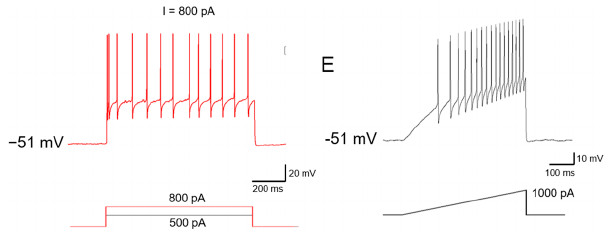
Figure 1. ( A ) Showing intact whole mount dorsal root ganglion (DRG) preparations (red arrow: whole mount DRG, scale bar: 2 mm); ( B ) Showing large-diameter DRG neurons from an intact whole mount